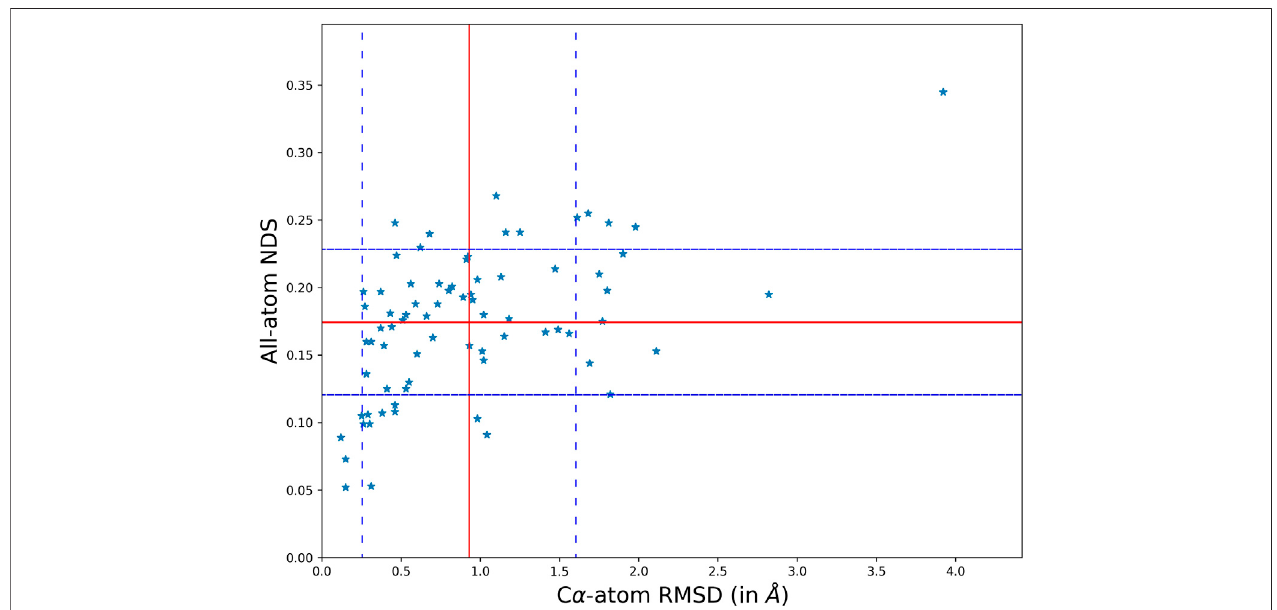
FIGURE 1 | A scatter plot comparing the structural topology (C α positions) and PSN of the wildtype and mutant using RMSD and NDS respectively. The comparison scores for each disease case are plot on the scatter. It is found that the structural divergence and network dissimilarity do not share strong linear